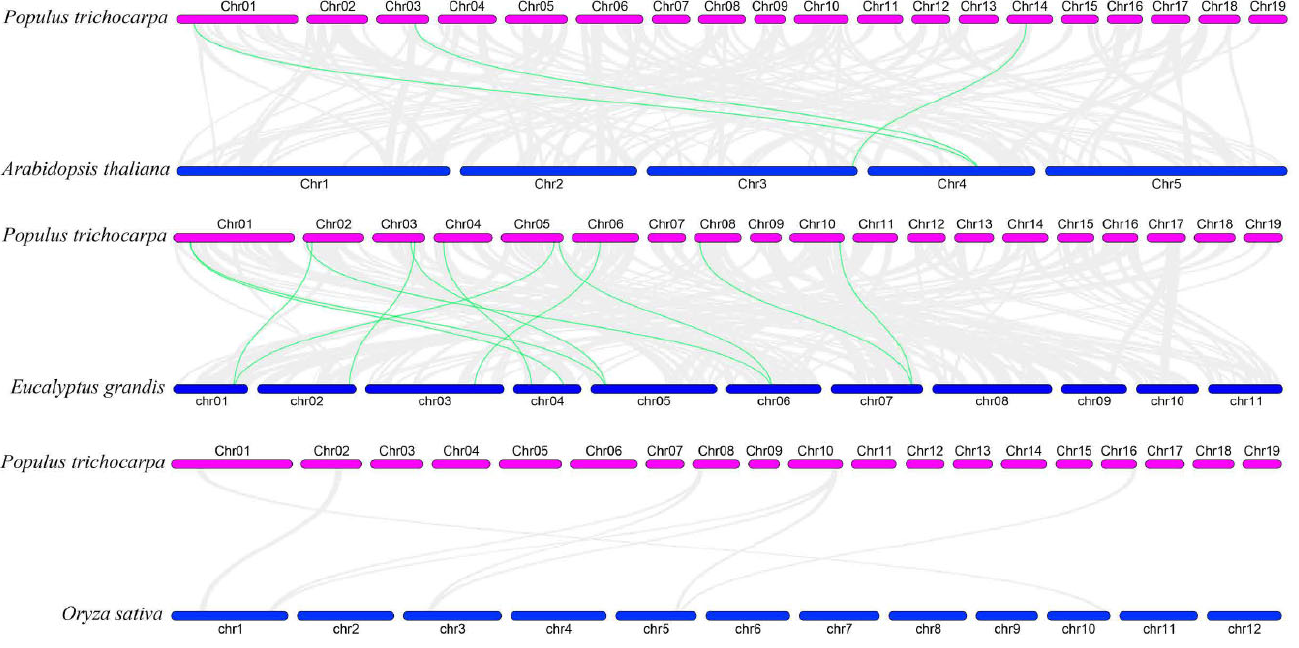
Figure 3. Synteny relationships of the ARF genes between poplar and three other plant species. The green lines highlight the syntenic ARF gene pairs, and the gray lines represent the collinear blocks in poplar that are orthologous to the other plant genomes.